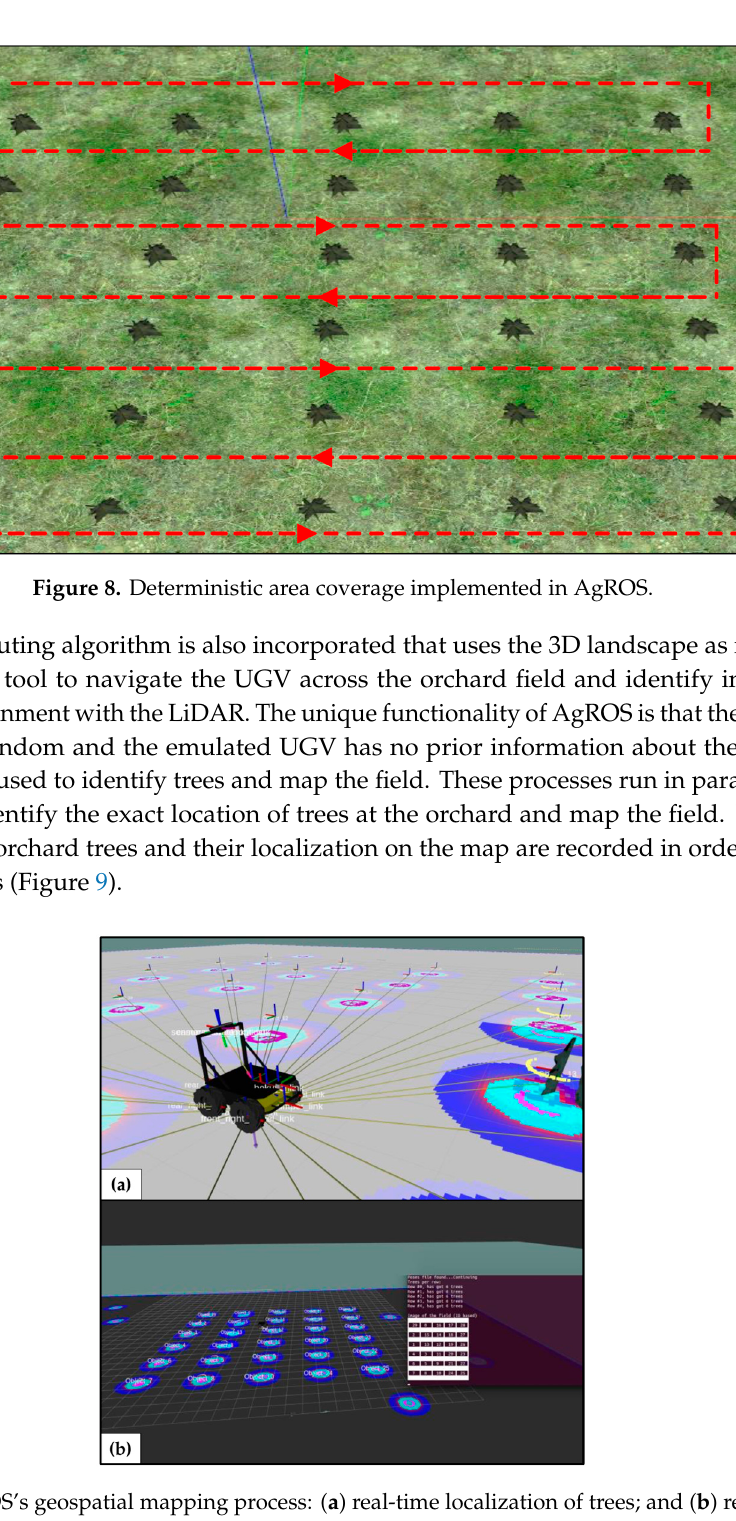
Figure 10. Dynamic area coverage by the UGV in AgROS. 4.4. Real-World Implementation In the AgROS emulation environment the model of an experimental four-driving-wheels four- steering-wheels electric-powered field robot and the source code were tested on a specified orchard.